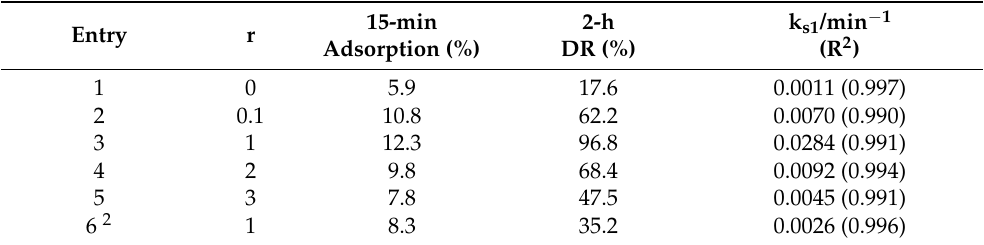
Figure 1. Catalytic degradation of OG with H 2 O 2 over F-Fe 3 O 4 -r (r = 0–3). ( a ) C t /C s -time plots and ( b ) ln(C 0 /C t )-time plots. Reaction conditions: OG (0.1 mM, pH 6.8), H 2 O 2 : 40 mM, and catalyst loading: 0.5 g/L at 40 ◦ C. Table 1. Effect of fluorination on catalytic performances of F-Fe 3 O 4 -r microspheres for the OG decolorization 1